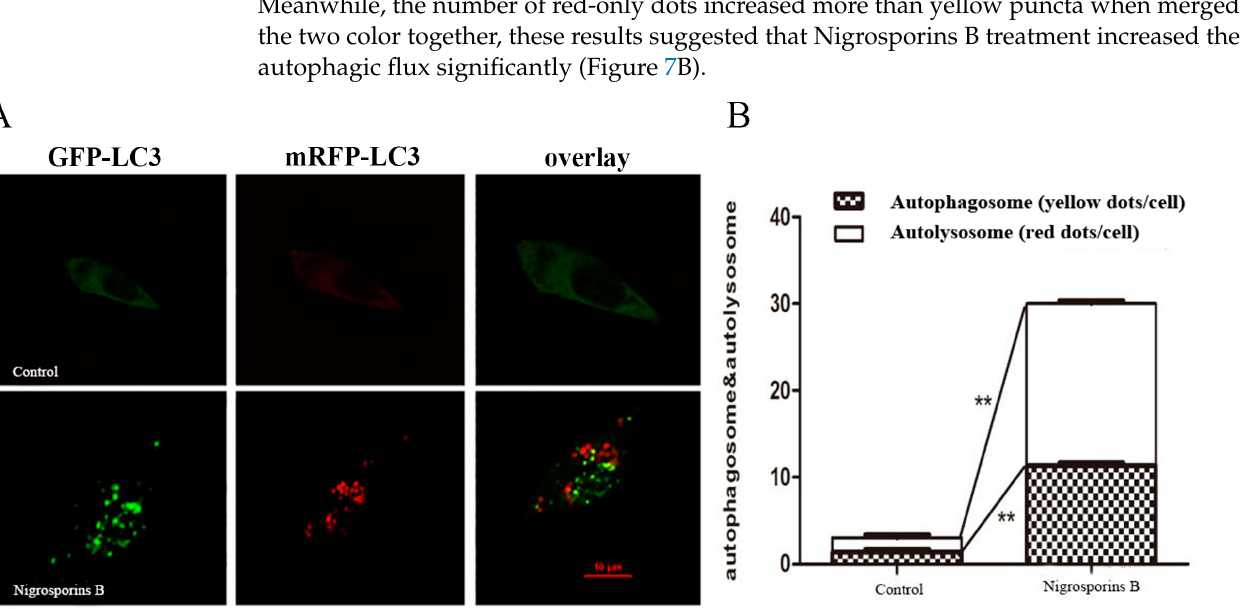
Figure 8. Nigrosporins B affected the expression of autophagy-related proteins in Ca Ski cells, cells were treated with Nigrosporins B for 24 h. ( A ) Representative western blotting bands of LC3-II/LC3- I, Beclin-1, p-Beclin-1, ULK1, p-ULK1, p62, ATG3, ATG4B, ATG5, ATG7 and ATG12; ( B ) and ( C ) Protein expression of LC3 II/I, Beclin-1, p-Beclin-1, ULK1, p-ULK1, p62, ATG3, ATG4B, ATG5, ATG7 and ATG12 (** p < 0.01, *** p < 0.001).